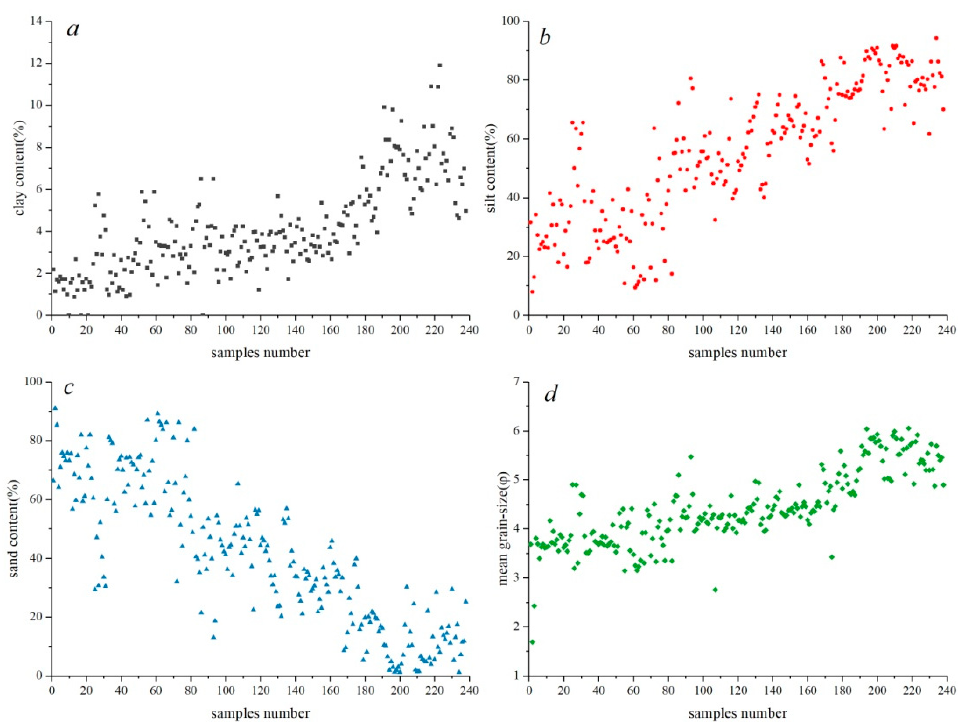
Figure 3. The measured content of clay ( a ), silt ( b ), sand ( c ), and the mean grain-size ( d ) of the collected samples.